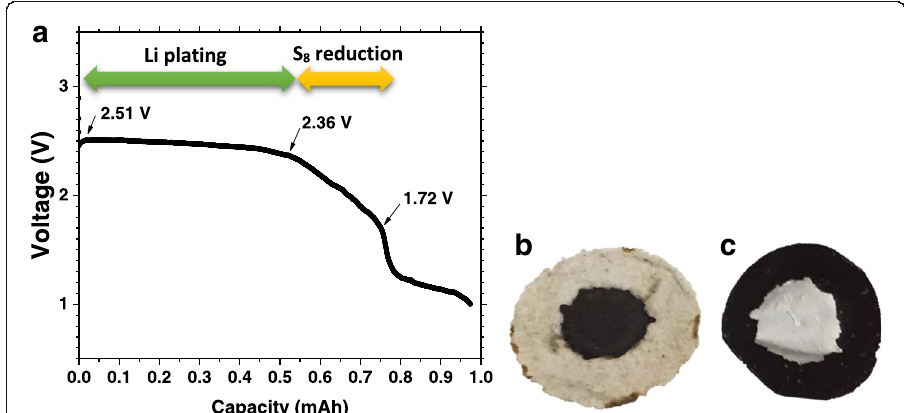
Fig. 8 Primary SS + Li/Li-glass/S + C + Al + SS cell. a discharge cycle. S 8 is not reduced while the cell voltage varies from 2.51 to 2.36 V; in this voltage range, Li was plated. From 2.36 to 1.3 V, S 8 reduction occurs. The S 8 reduced corresponded to around 1/10 of the S 8 in the positive electrode. b Photograph of the positive electrode on the paper matrix containing the Li-glass electrolyte; lithium of the negative electrode (not shown) is on the opposite side of the glass-on-paper. c The removed Al-positive electrode current